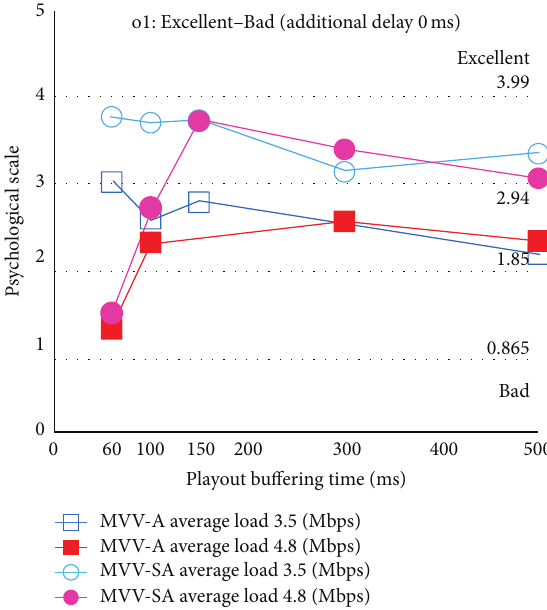
Figure 9: Overall satisfaction: additional delay 0 ms.